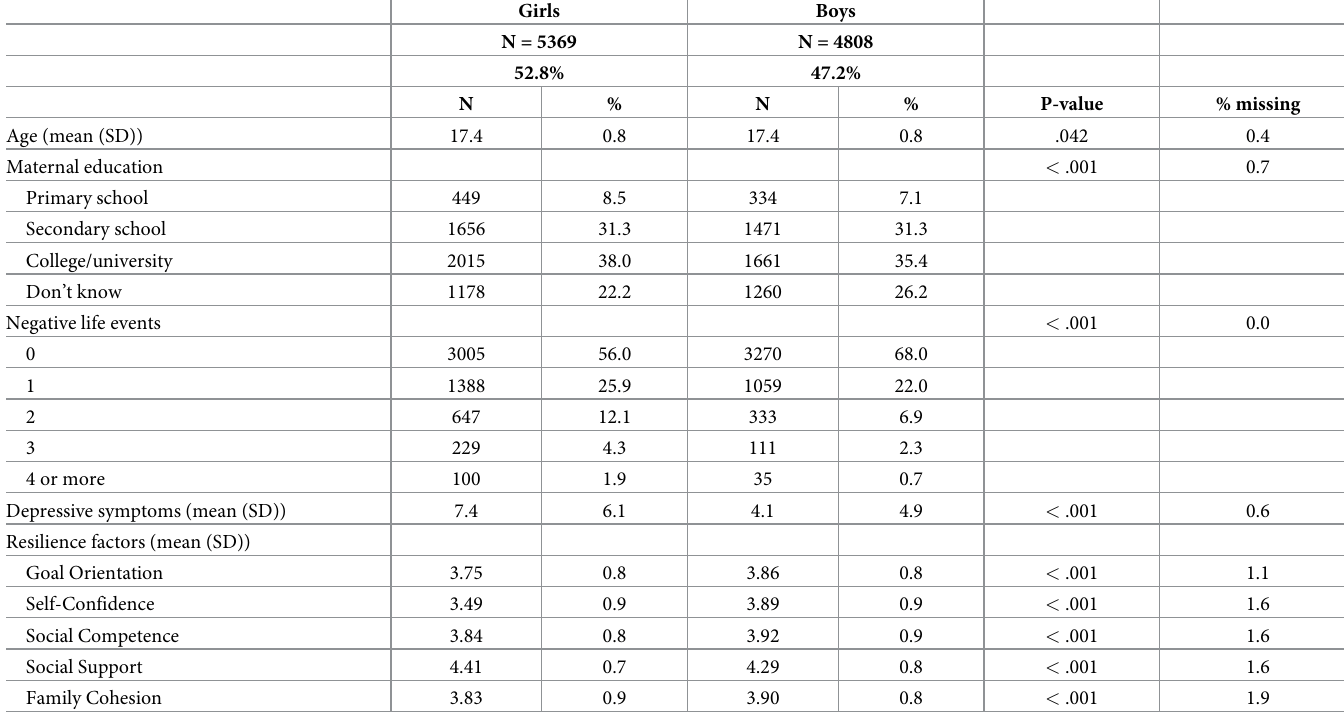
Table 1. Demographic characteristics and background